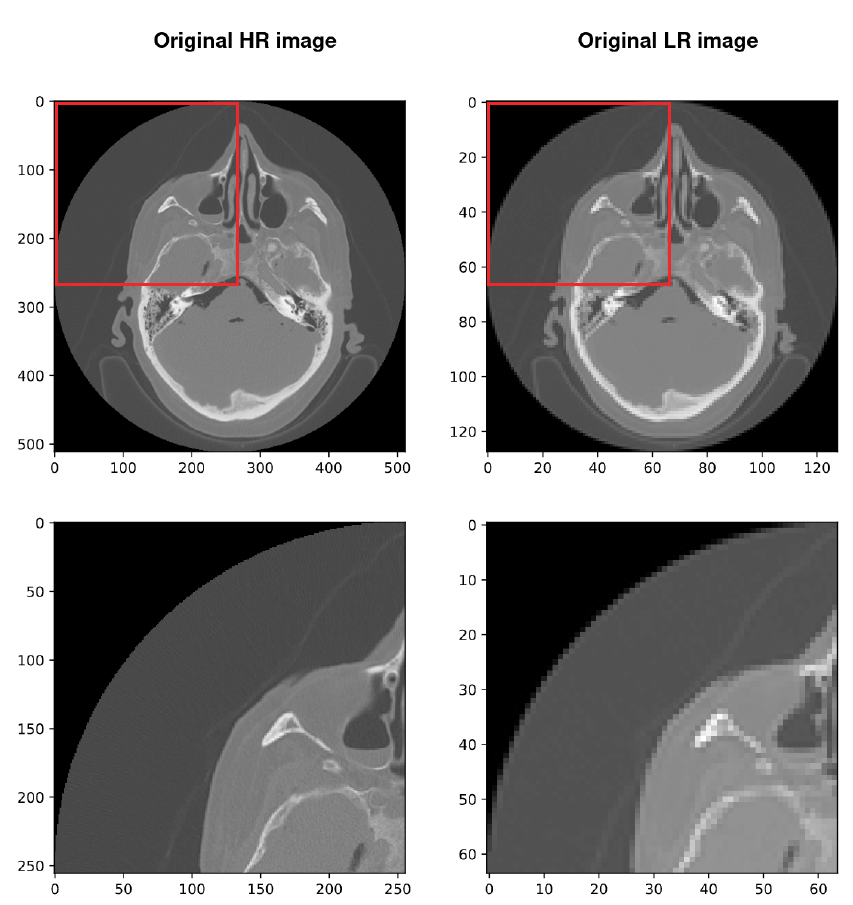
Figure 3. Left column shows the high-resolution slices with a size of 512 × 512 and the right is the low-resolution slices with a size of 128 × 128. Low-resolution slices were obtained by applying Lanczos resampling on the high-resolution